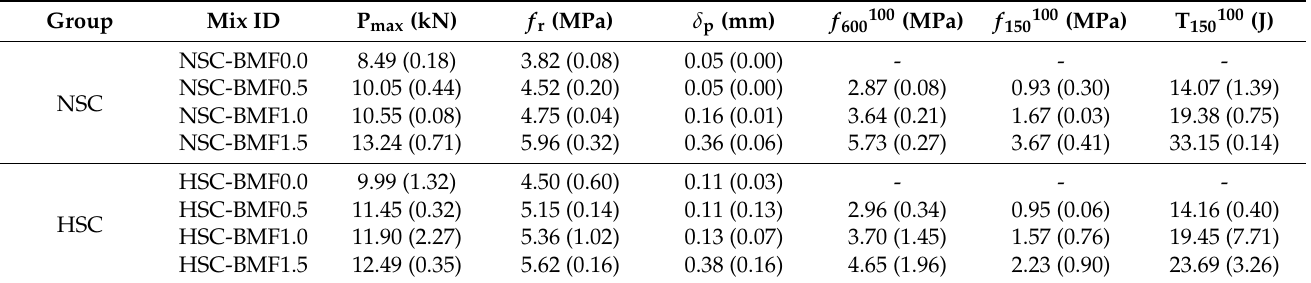
Table 8. Four-point flexural test results.